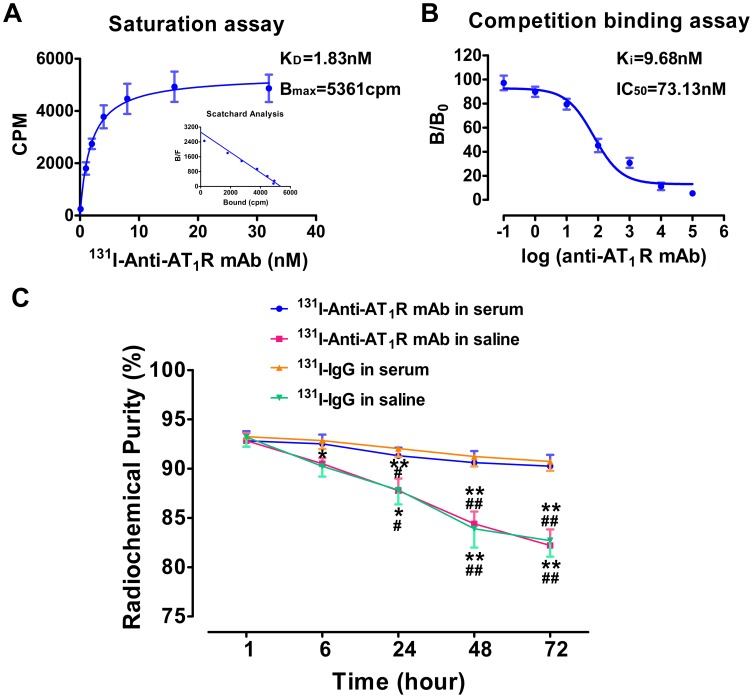
The affinity and stability of 131I-AT1R mAb and 131I-IgG.(A) The saturation assay of 131I-AT1R mAb. KD, equilibrium dissociation constant; Bmax, maximum number of binding sites. (B) The competition binding assay of 131I-AT1R mAb. Ki, inhibitor constant; IC50, half maximal inhibitory concentration. (C) The radiochemical purity of 131I-AT1R mAb and 131I-IgG. *P<0.05 and **P<0.01 vs. 1 hour; #
P<0.05 and ##
P<0.01 vs. the same time-point in serum.